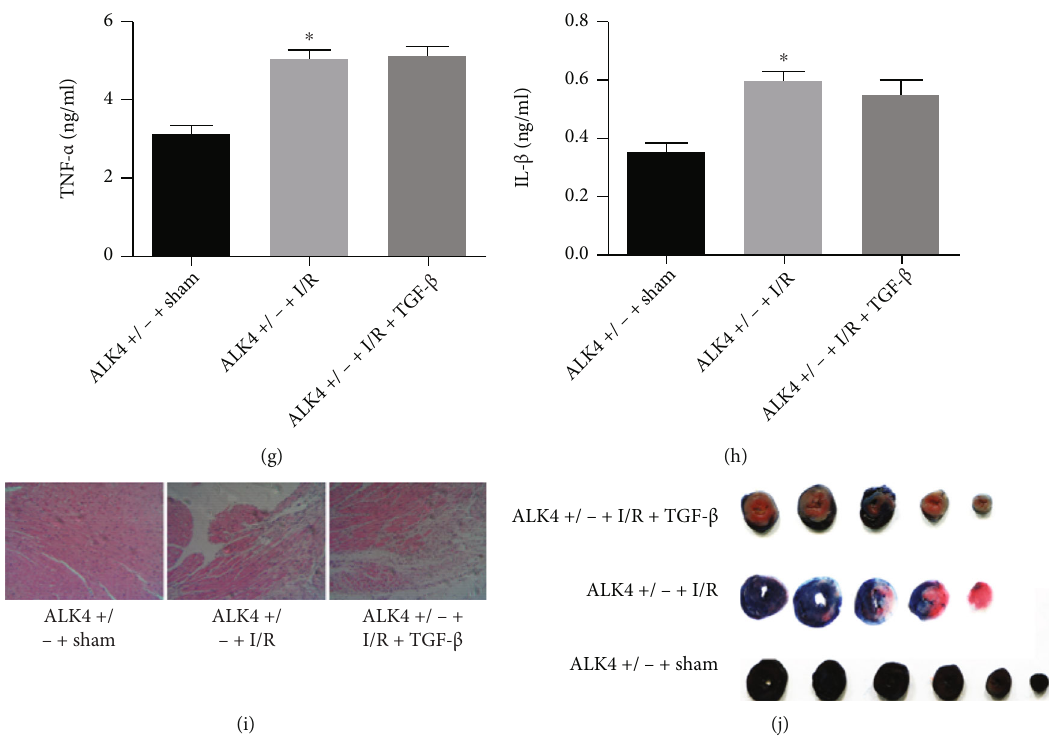
Figure 8: In the cell model of hypoxia/reoxygenation, TGF- β was knocked out, and exogenous ALK4 protein was added. HE staining of heart tissues. The aging condition: ALK4 +/ − + I/R group = ALK4 +/ − + I/R and TGFbgroup > ALK4 +/ − + sham group . Evans blue and TTC staining found no signi fi cant change in myocardial infarction area after addition of TGF- β , followed by detection of SOD, MDA, CK, LDH, AST, IL-6, TNF- α , and IL-1 β . There was no signi fi cant di ff erence between ALK4 +/- +I/R and TGF- β groups, and it was signi fi cantly higher than the ALK4 +/- +sham groups. (a – h) Antioxidation-related indicators and in fl ammation-related indicators TNF- α , IL-6, and IL-1. (i) HE staining. (j) Evans Blue and TTC double